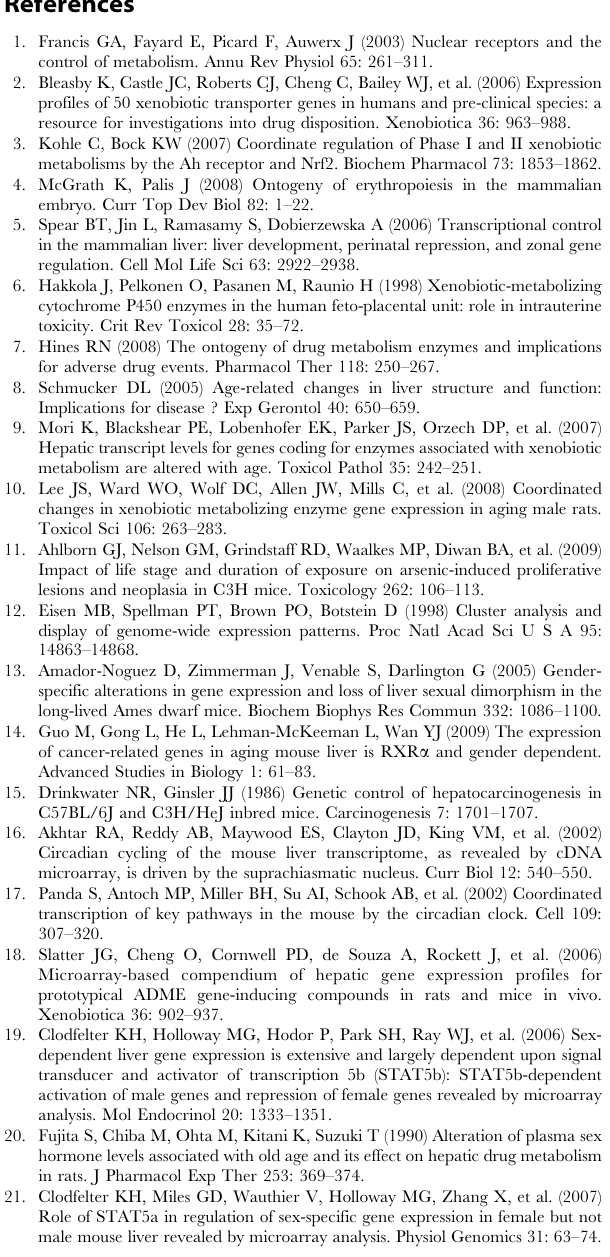
Table S4 Impact of life stage on phase II metabolism genes. (XLSX) Table S5 Impact of life stage on phase III transporter genes. (XLSX) Table S6 Impact of life stage on transcriptional regu- lators of XMET expression. (XLSX) Table S7 RT-PCR confirmation of microarray results. Expression of xenobiotic metabolism genes from GD19-PND67 was determined by RT-PCR. Significant fold-changes (p # 0.05) are indicated.